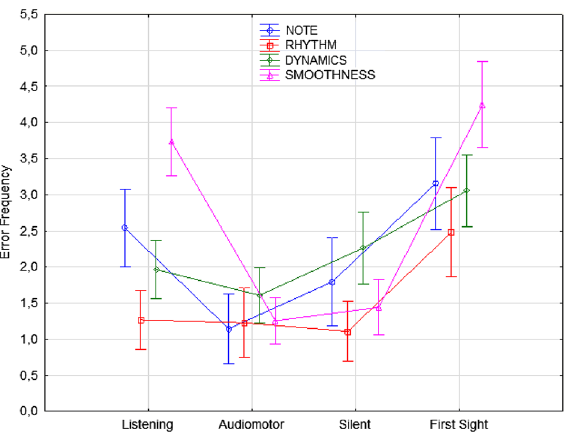
Figure 8. Error frequency observed in the various learning conditions and as a function of error type (regardless of the students’ level and instrument played). Error bars indicate standard